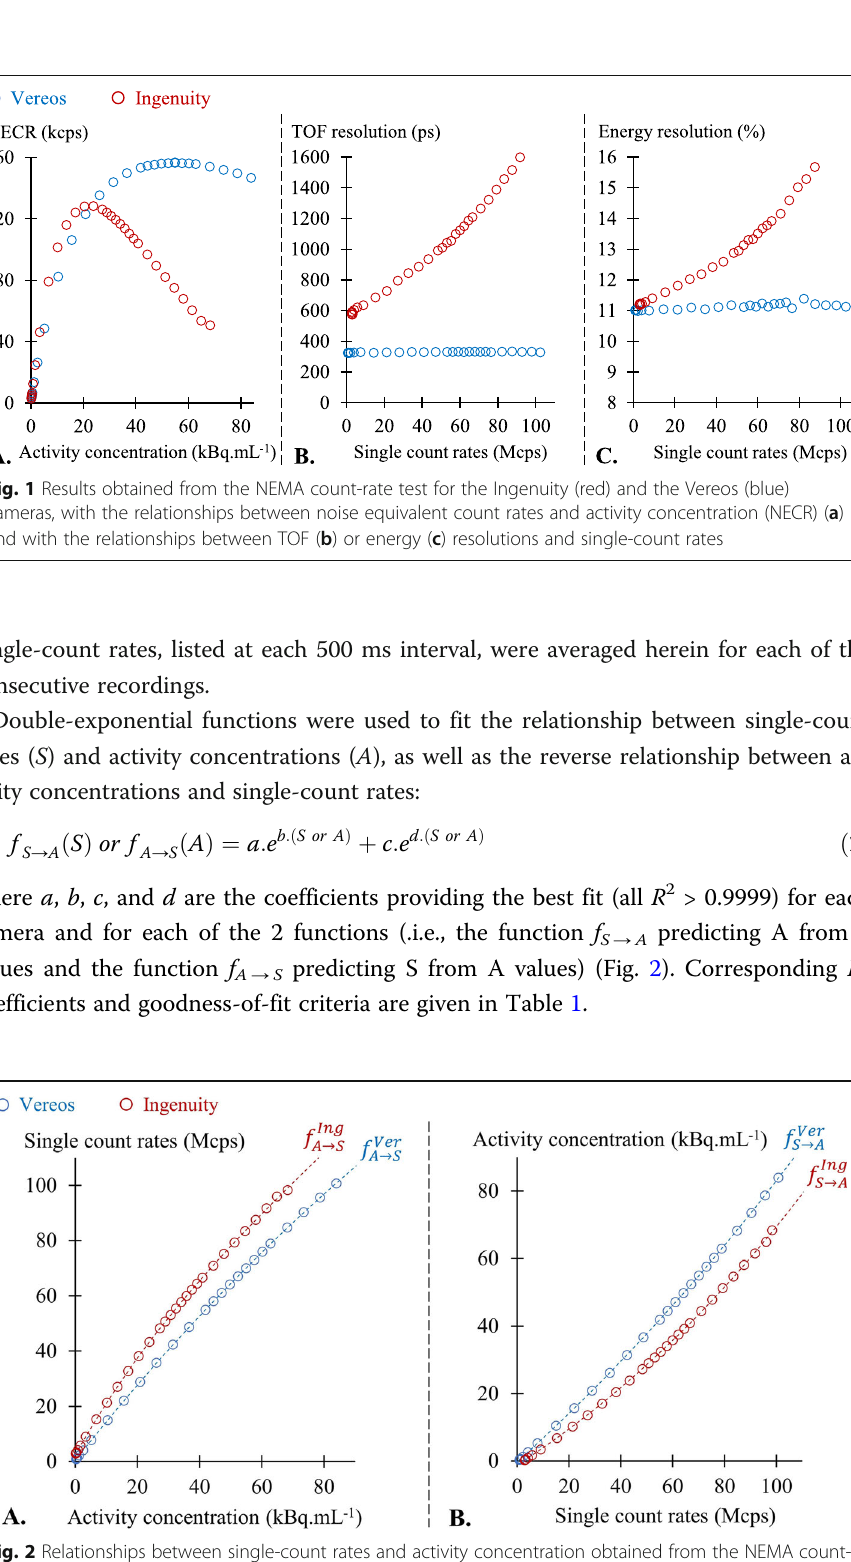
and f Ver for respectively Ingenuity A → S and f Ver for respectively S → A